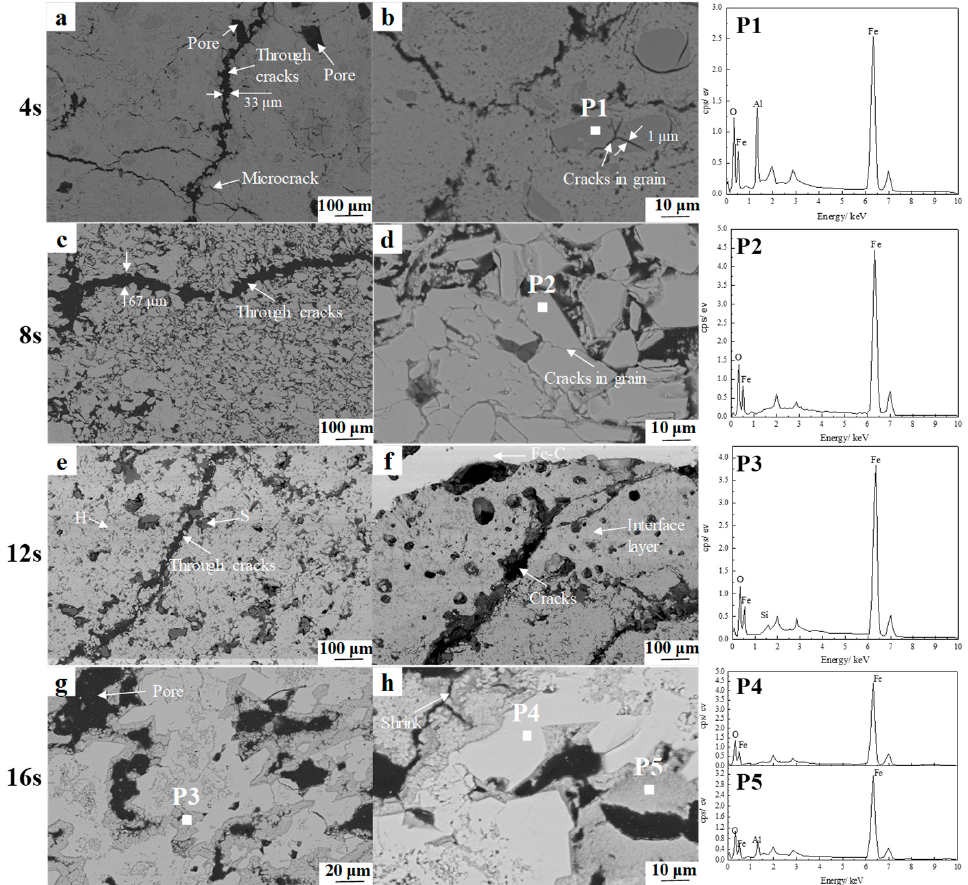
Figure 6. Internal cracking microstructure during the smelting reduction of #1 iron ore. ( a ) Micro- structure of cracks at 4 s with 100 μ m scale; ( b ) Microstructure of cracks at 4 s with 10 μ m scale; ( c ) Microstructure of cracks at 8 s with 100 μ m scale; ( d ) Microstructure of cracks at 8 s with 10 μ m scale; ( e ) Microstructure of cracks at 12 s with 100 μ m scale; ( f ) Microstructure of cracks at 12 s with 100 μ m scale; ( g ) Microstructure of cracks at 16 s with 20 μ m scale; ( h ) Microstructure of cracks at 16 s with 10 µ m scale; ( P1 ) EDS results in ( b ); ( P2 ) EDS results in ( d ); ( P3 ) EDS results in ( g ); ( P4 ) EDS results in ( h ); ( P5 ) EDS results in ( h